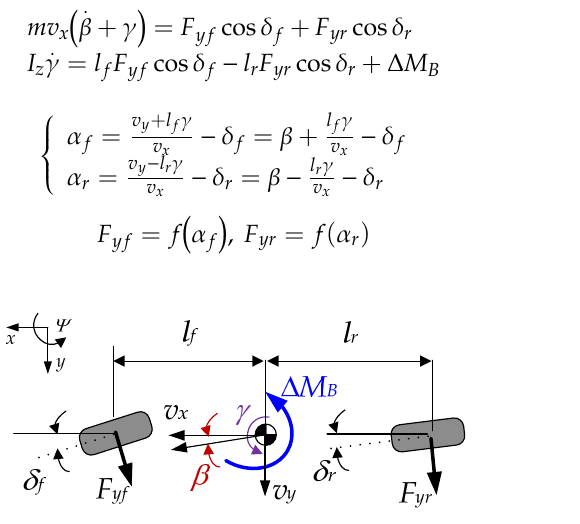
Figure 3. 2-DOF bicycle model.